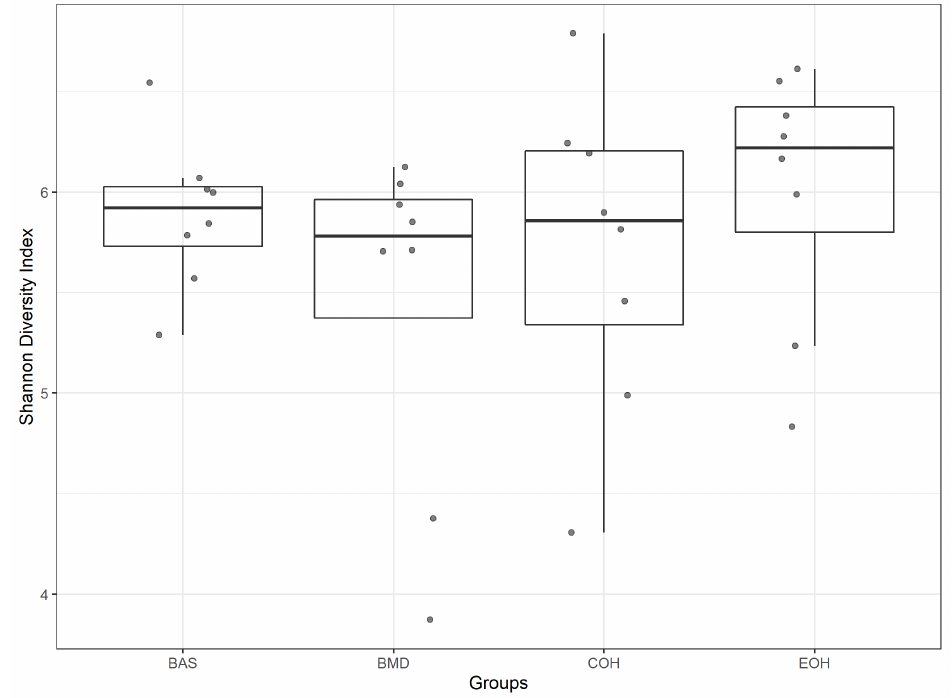
Figure 2. Alpha diversity (Shannon index) was computed and illustrated for each sample. BAS = basal diet; BMD = antibiotic diet; COH = diet supplemented with 3% coarse oat hulls; and EOH = diet supplemented with 3% extruded oat hulls.